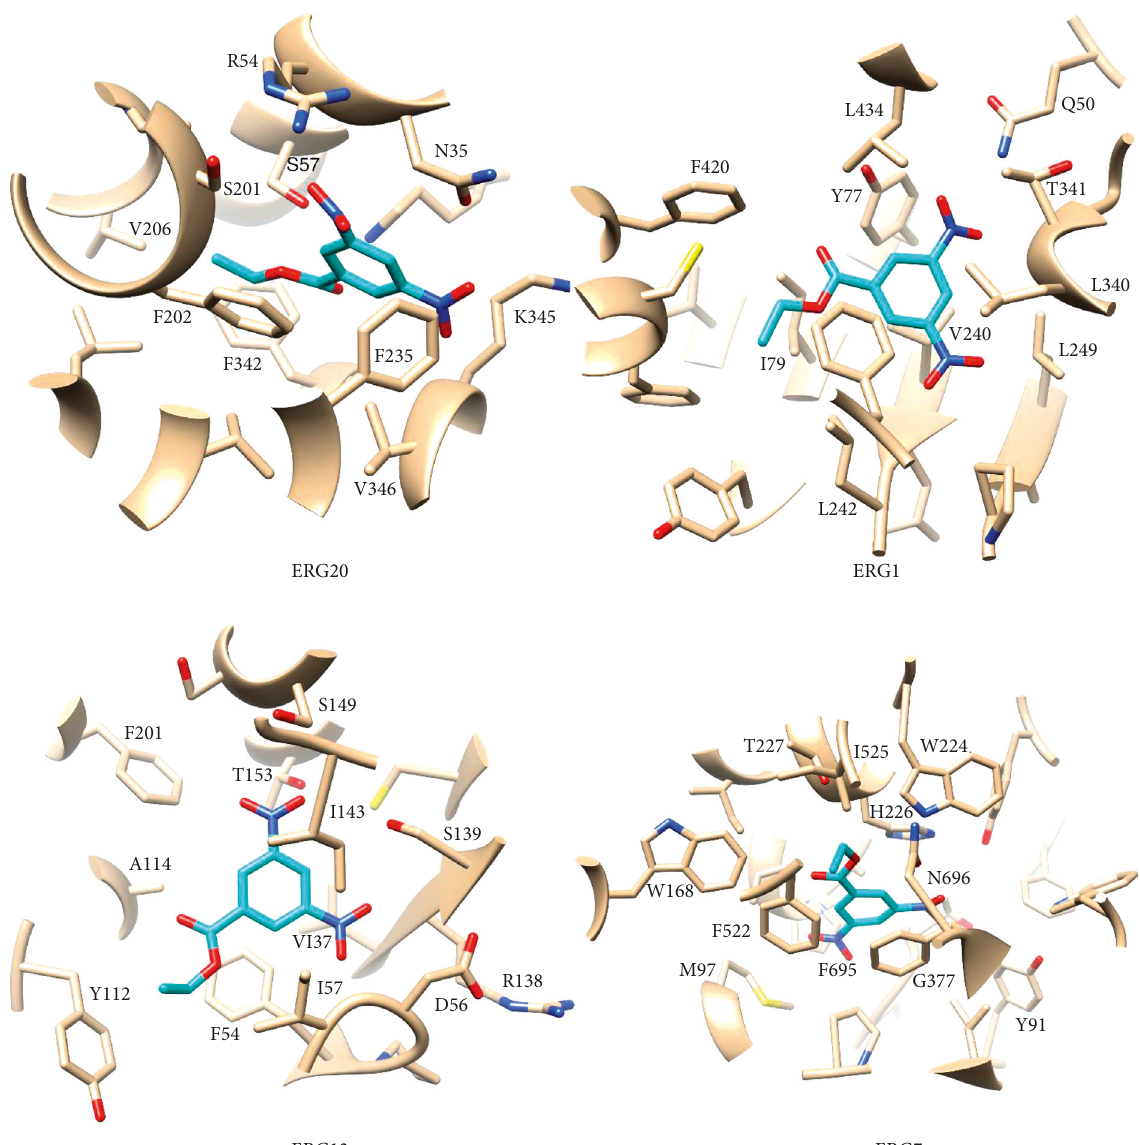
Figure 3: Predicted binding modes of compound 2 to the ERG20 (top left), ERG1 (top right), ERG12 (bottom left), and ERG7 (bottom right) targets. Non-carbon atoms are colored following the scheme: red for oxygen, blue for nitrogen, and yellow for sulfur. Only residues interacting with the compound in more than 50% of the analyzed MD snapshots are labelled in the